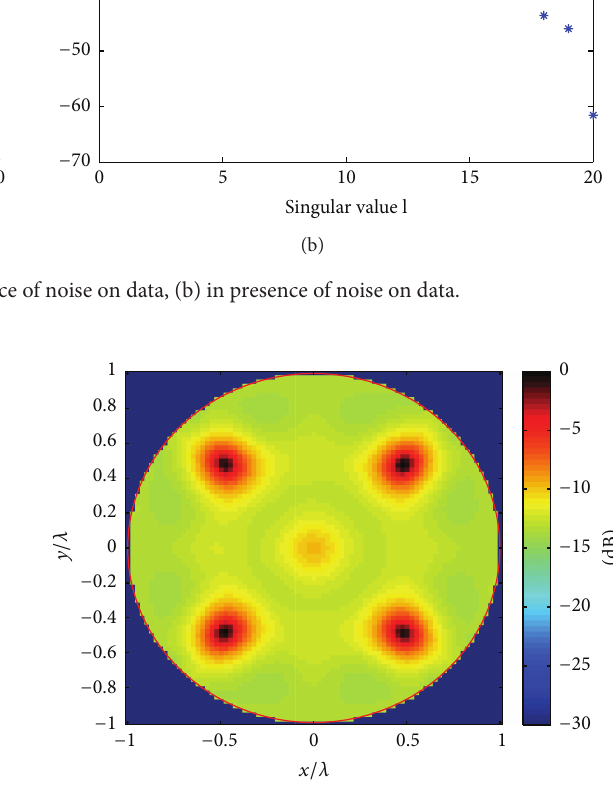
Figure 4: TRM choosing the threshold singular values at 𝑛 = 4